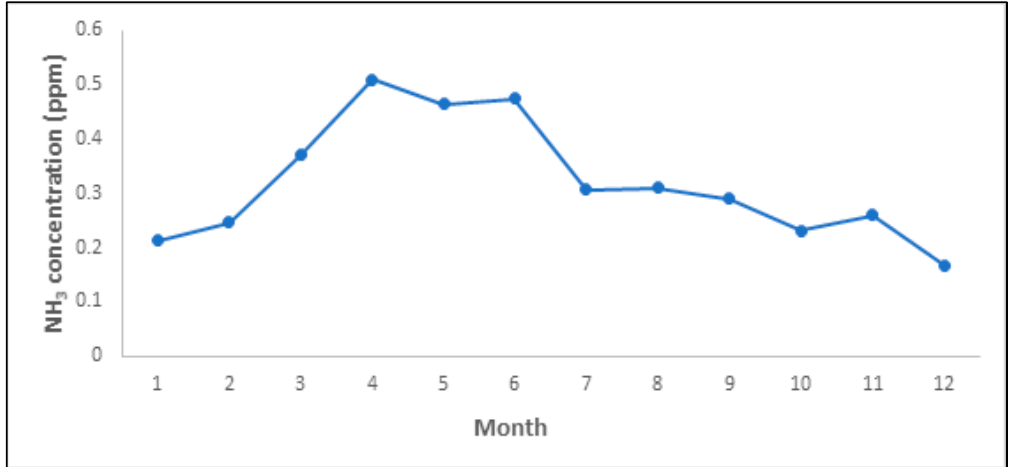
Figure 3. Monthly trend of NH 3 concentrations at NPK fertilizer production plants.